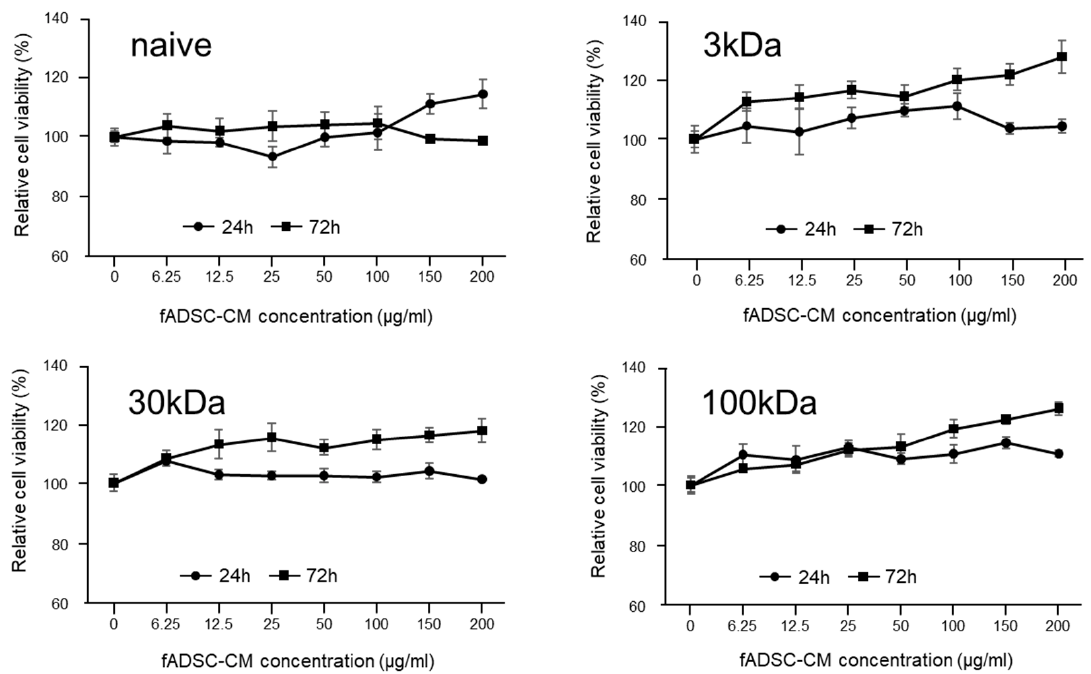
Figure 1. Cytotoxic effects of fADSC-CM treatment on CRFK cells. Cells were treated with 0–200 µ g/mL of fADSC-CM for 24 h and 72 h. Relative cell viability was determined by CCK8 assay and normalized to the value of the 0 µ g/mL group (set at 100%). Data are expressed as the mean ± standard